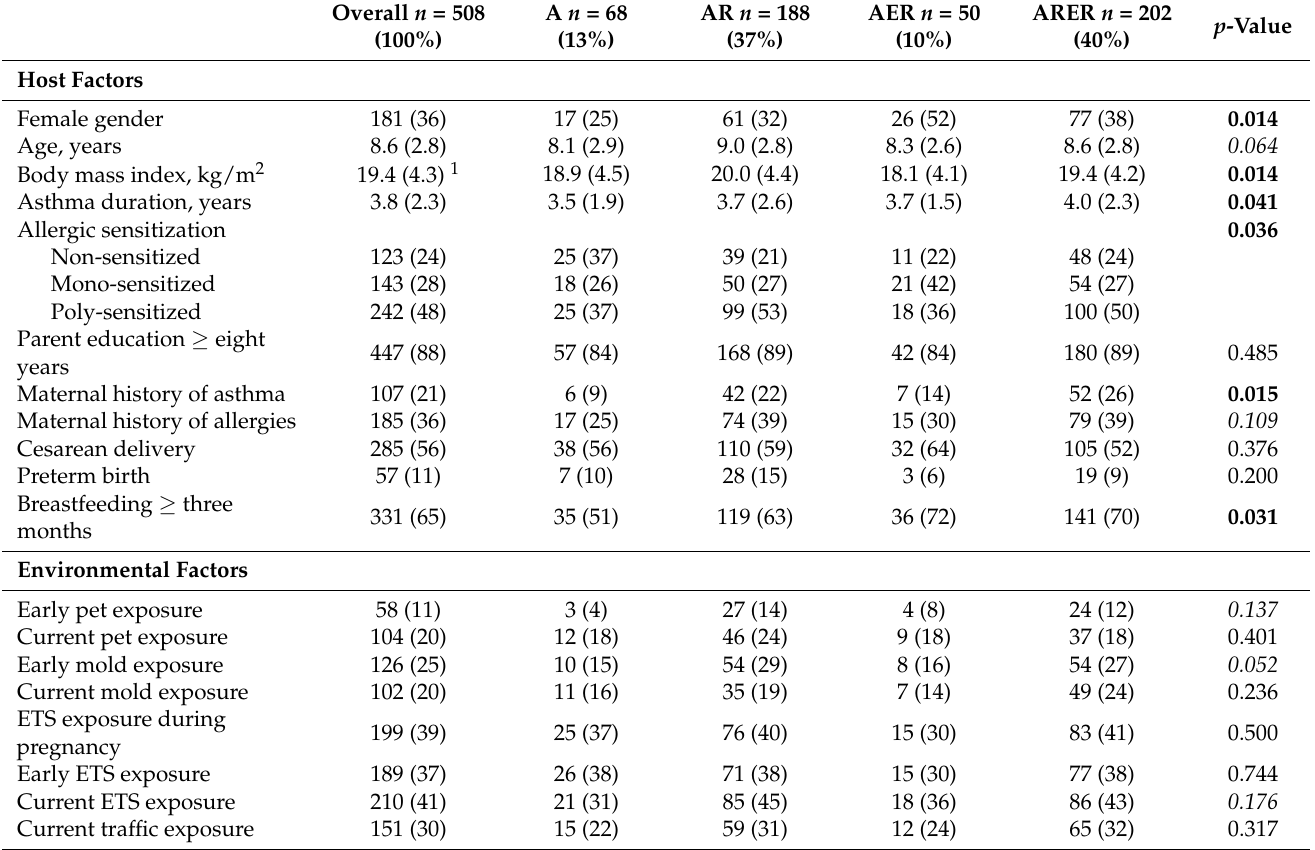
Table 2. Subject characteristics by comorbidity group.